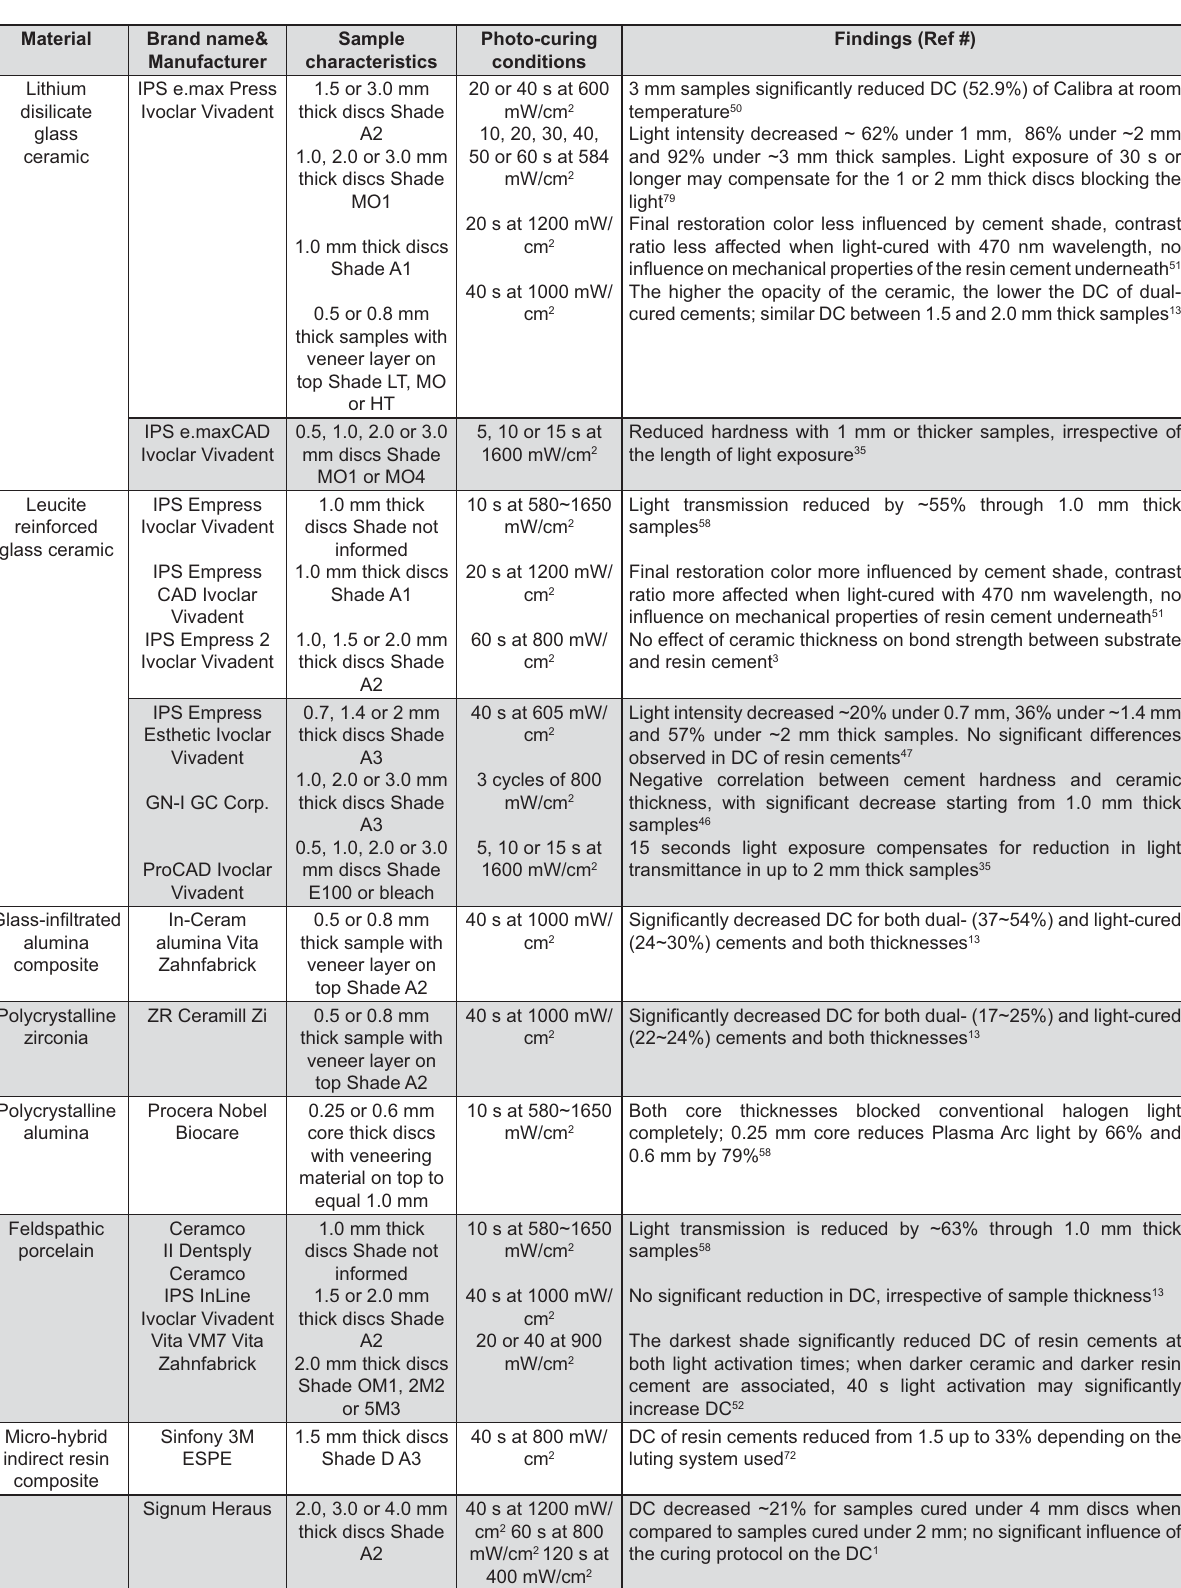
Figure 2- Correlation between indirect restorative materials and the curing properties of the resin